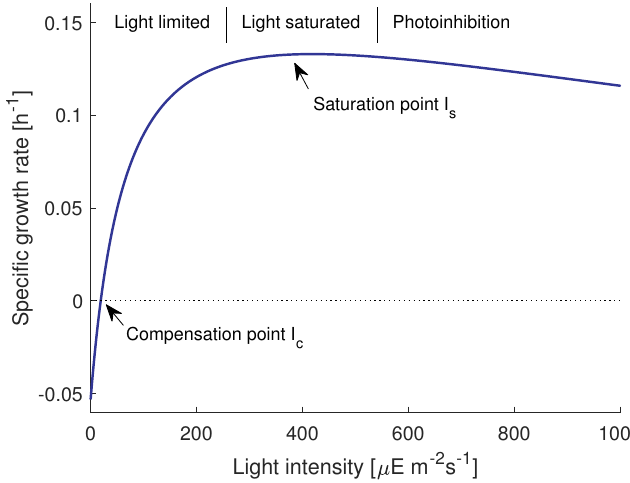
Figure 2. Schematic of photosynthesis-irradiance